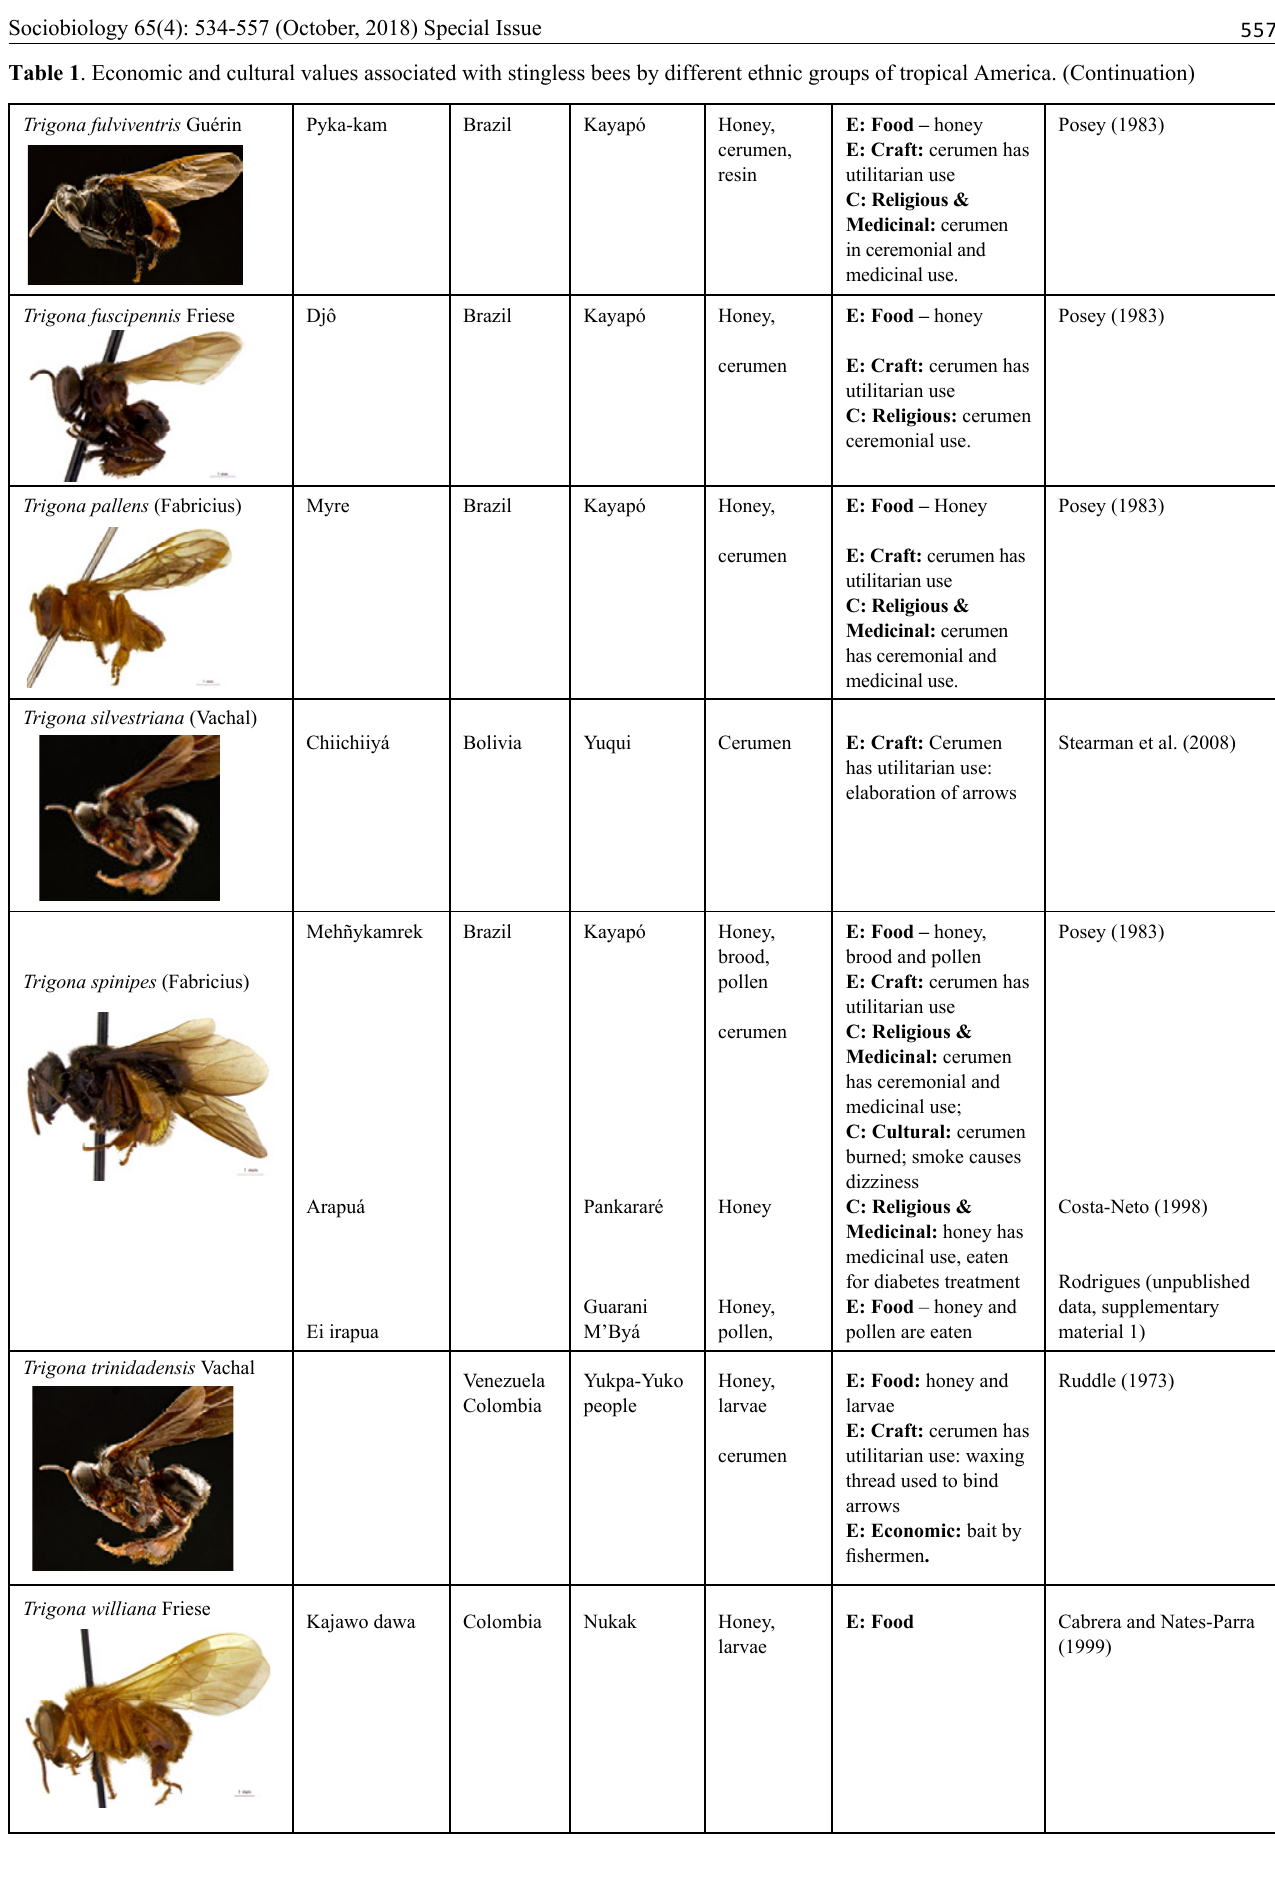
Table 1 . Economic and cultural values associated with stingless bees by different ethnic groups of tropical America.